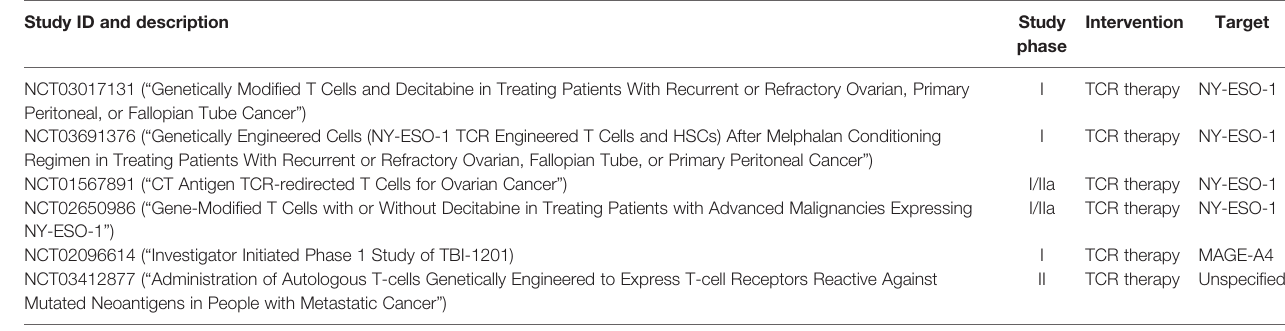
TABLE 1 | Summary of ongoing clinical trials for evaluating TCR therapy safety pro fi les in cancers including OC. Study ID and